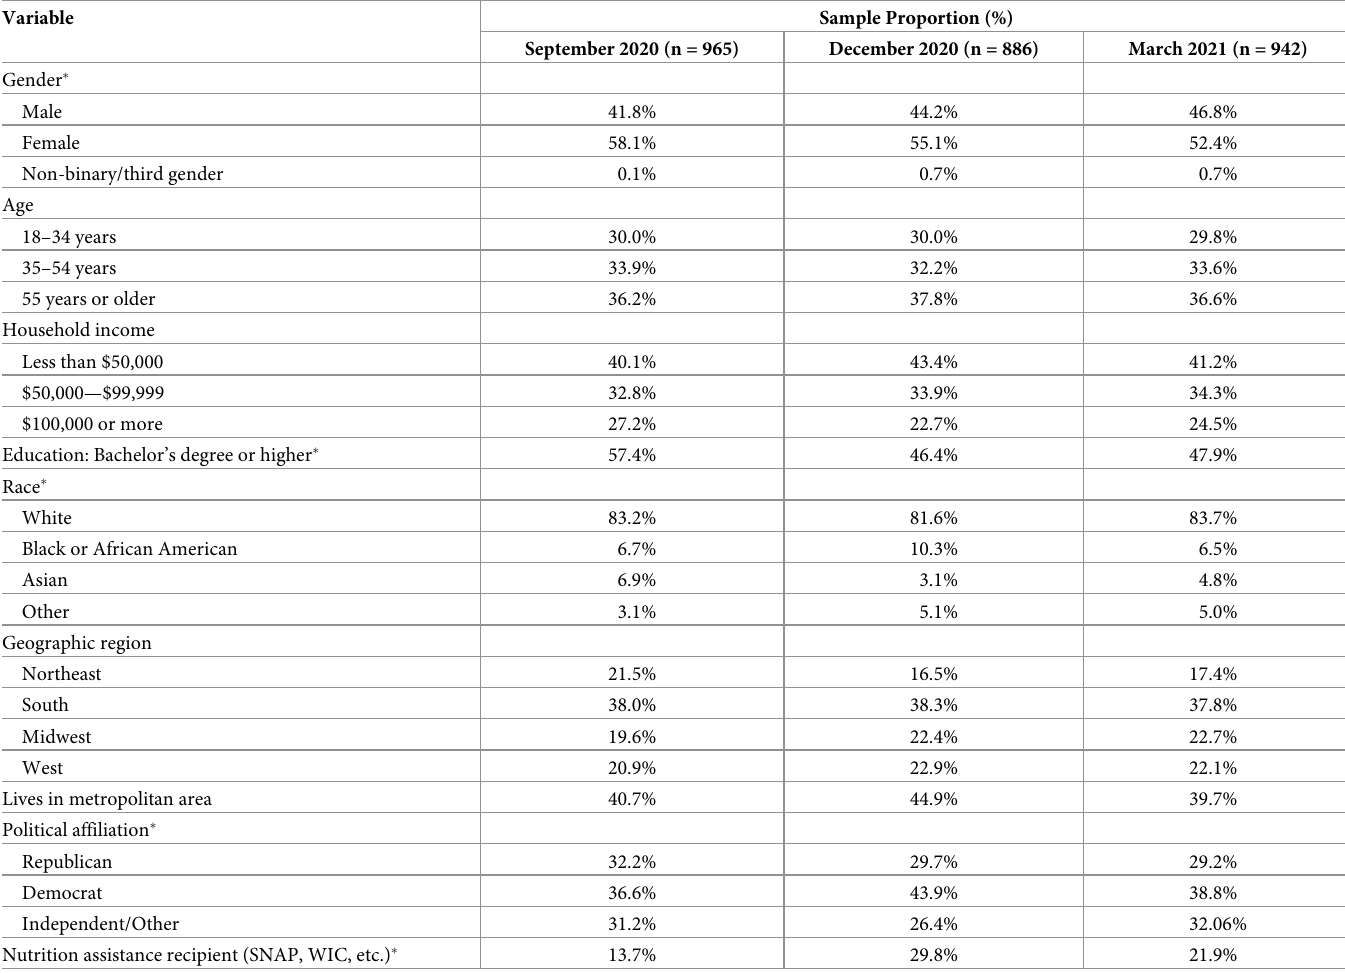
Table 1. Summary of sample characteristics by survey